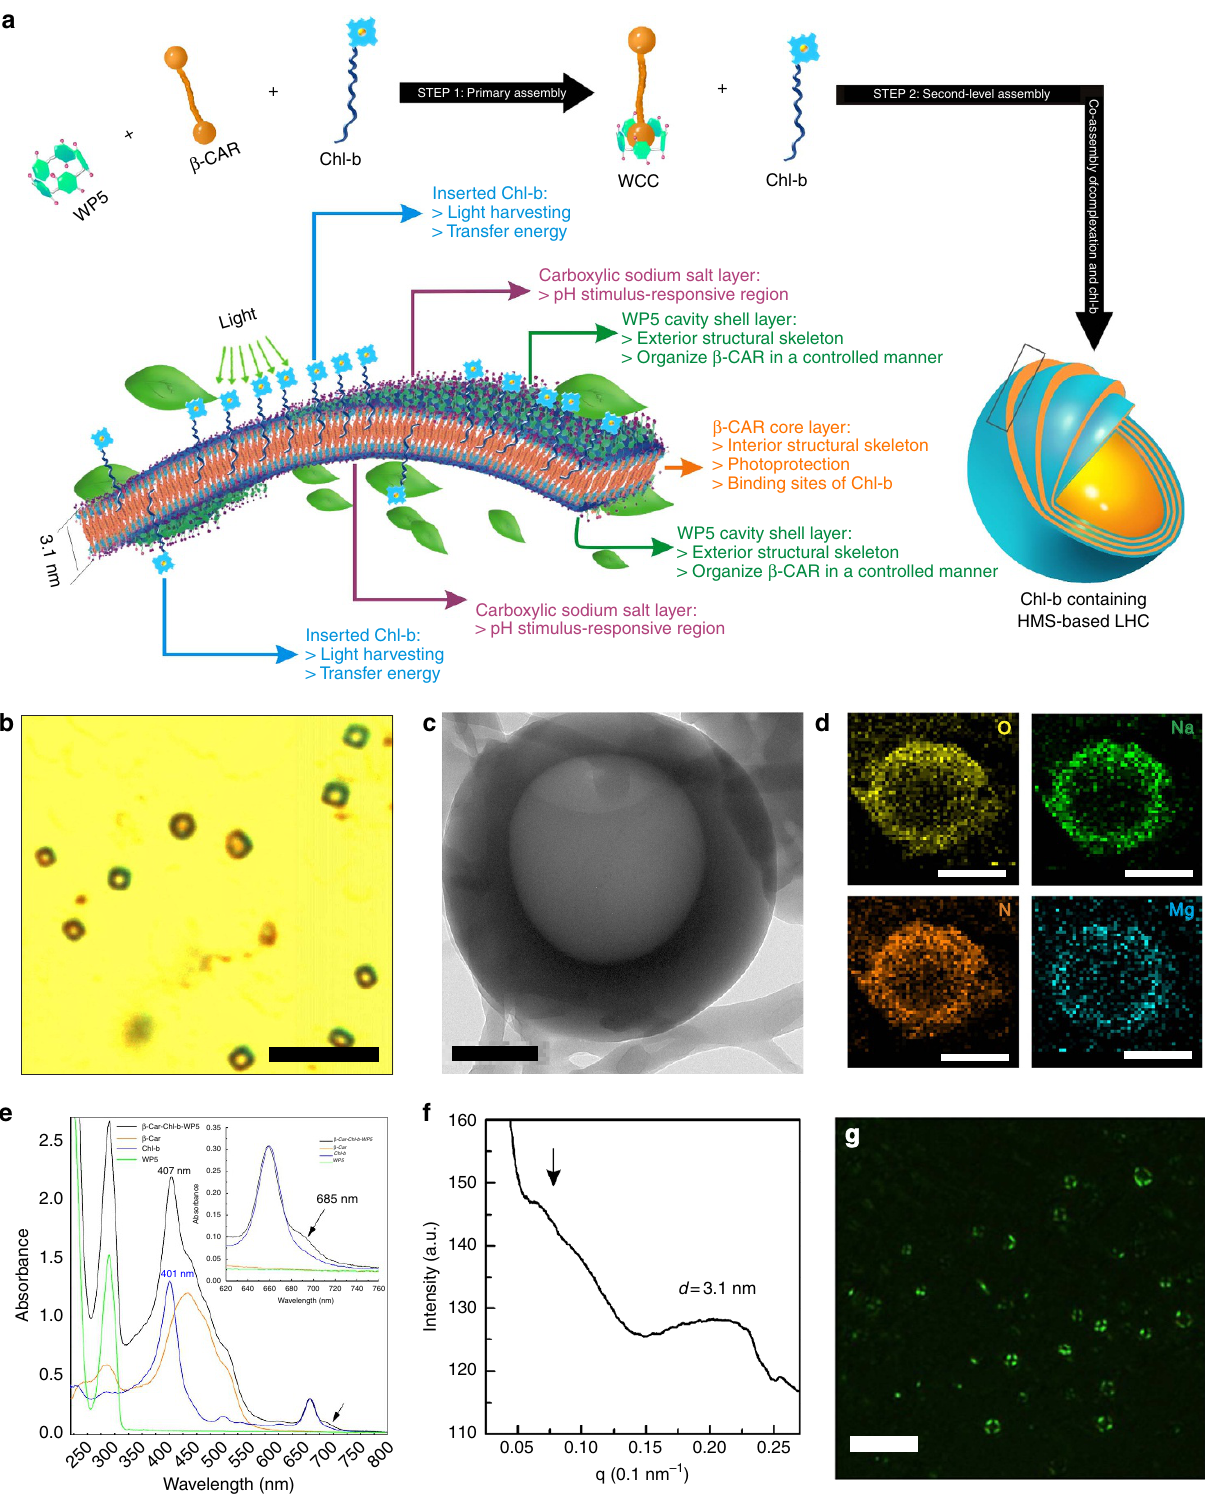
Figure 4 | Synthesis of HMS-based LHCs-b. ( a ) Synthesis of LHCs-b. ( b ) OM image showing LHCs-b. Scale bar, 10 m m. ( c ) TEM image of an LHCs-b. Scale bar, 200nm. ( d ) EDX mapping image of an LHCs-b (the colour in this image is false). Scale bar, 500nm. ( e ) Ultraviolet–visible spectra of b -CAR, Chl-b, WP5 and LHCs-b. ( f ) SAXS profile of an LHCs-b. ( g ) Polarized image of LHCs-b (the colour in this image is false). Scale bar, 10 m